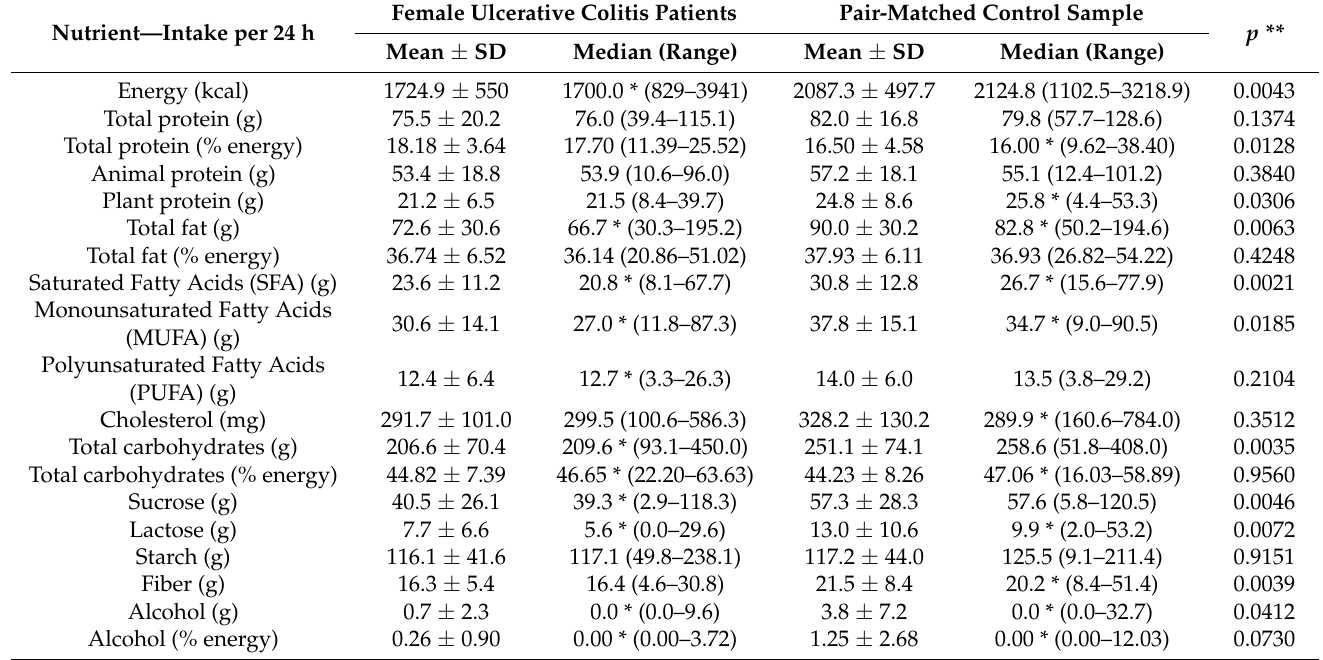
Table 1. The macronutrients intake in the studied Polish female ulcerative colitis individuals, in comparison with a pair-matched control sample.